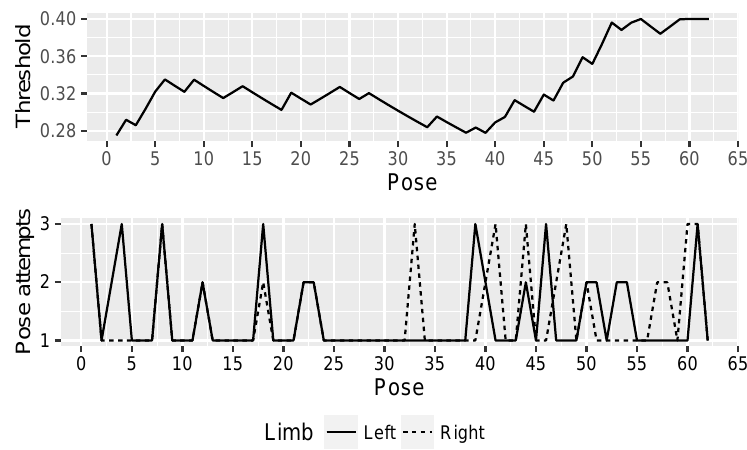
Figure 9. Patient P3: dynamic adaptation of NAOTherapist to the patient based on pose attempts.